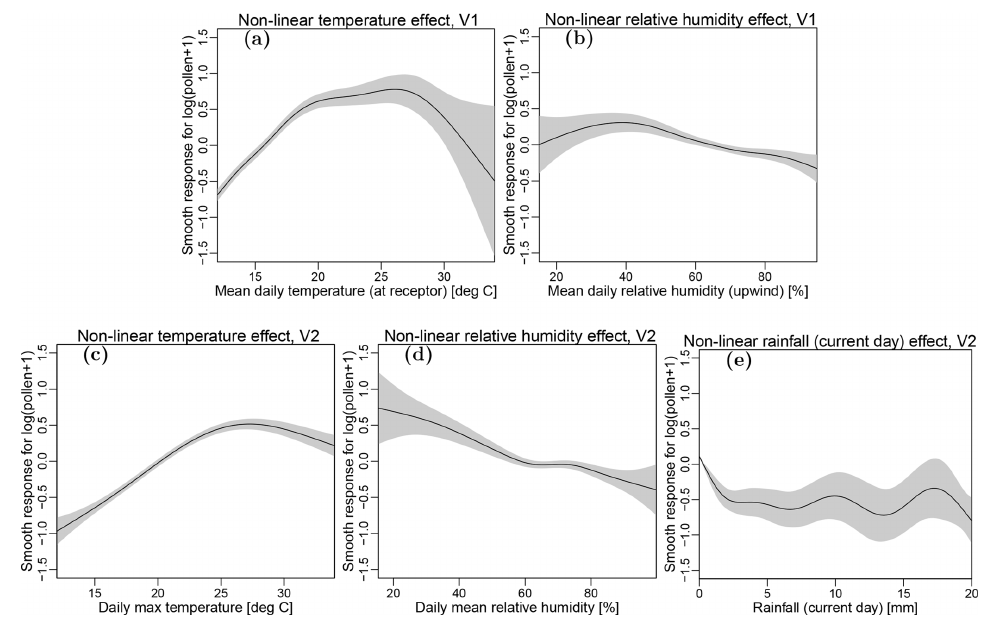
Figure 4. The shape of the non-linear terms in the statistical models related to temperature ( a and c ), relative humidity ( b and d ) and rainfall (e) for V1 ( a and b ) and V2 ( c , d and e ). The shaded regions correspond to plus or minus twice the standard error of the GAM